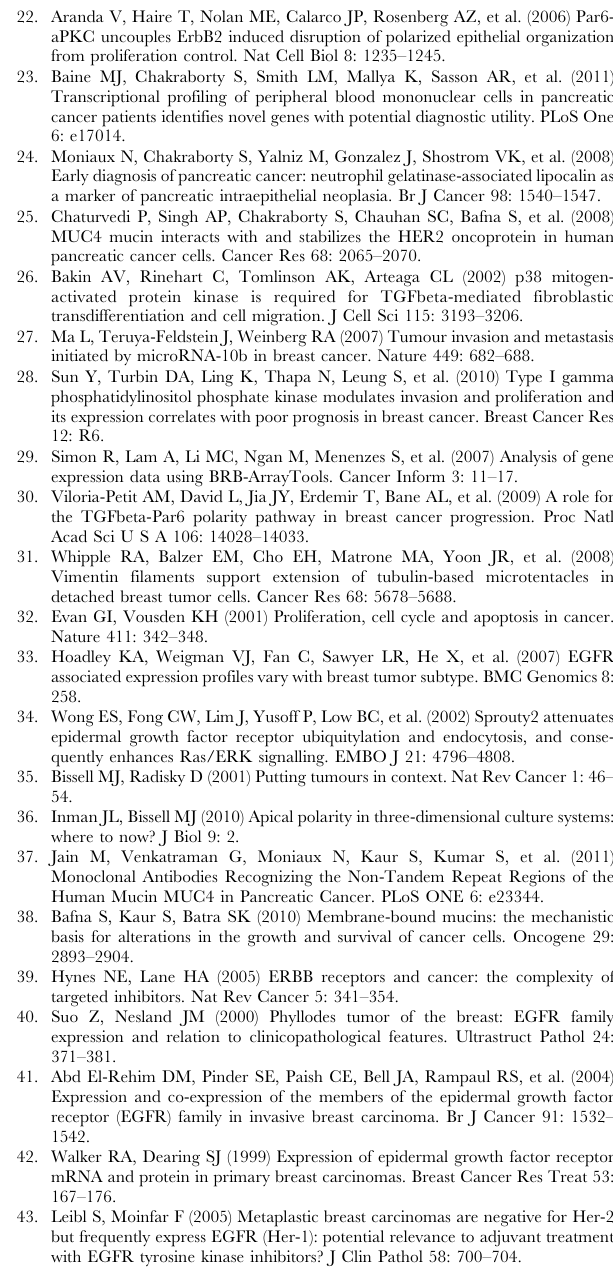
Table S2 List of primers that were used for real-time PCR analysis and validation of microarray